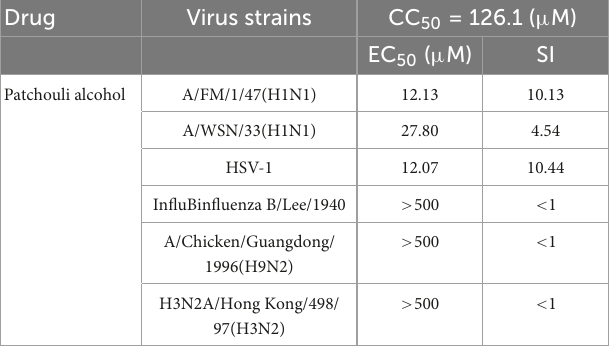
Patchouli alcohol